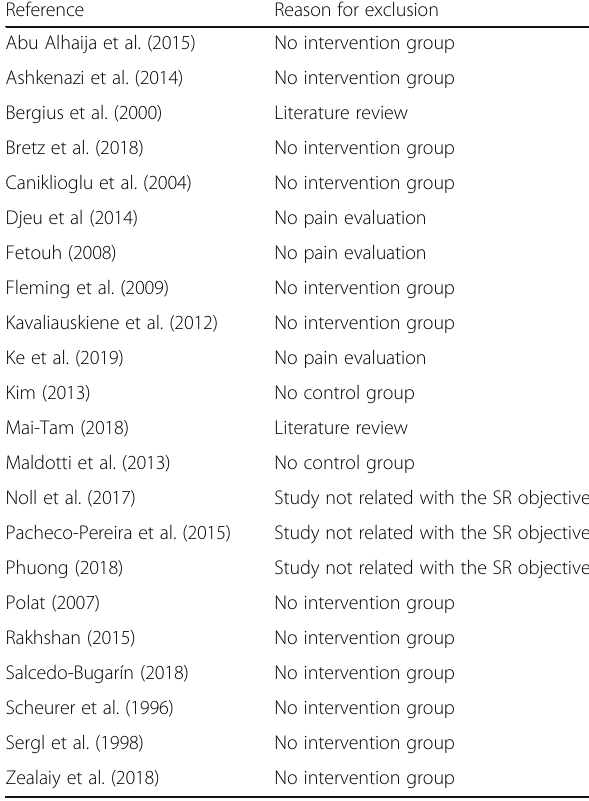
Table 5 List of excluded studies (with reason)